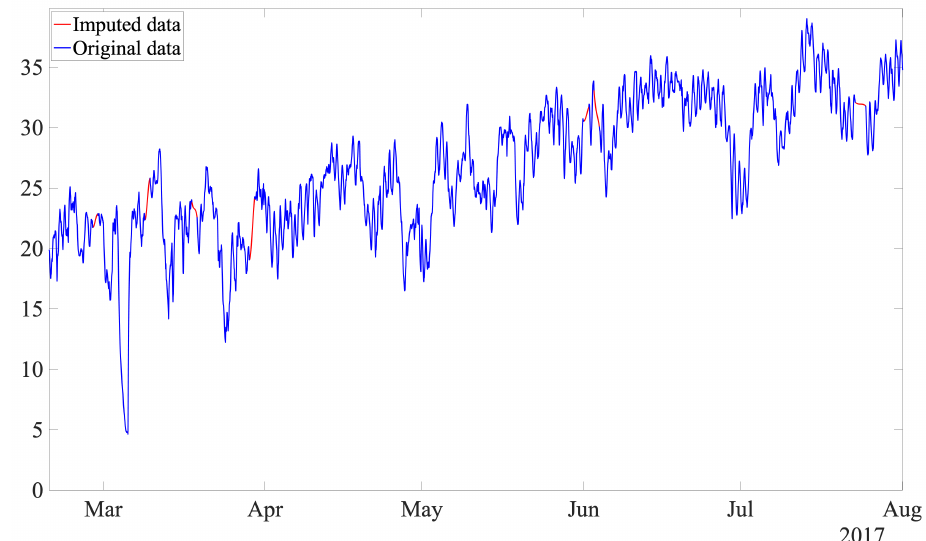
Figure 11. Low-speed shaft temperature raw data (without outliers) versus imputed data ( top ) and zoom in of the imputed data ( bottom